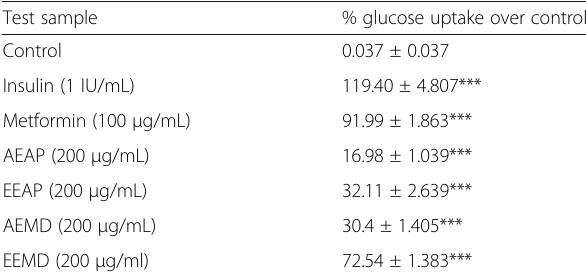
Table 4 In vitro glucose uptake activity by L-6 myotubes in the presence of plant leaf